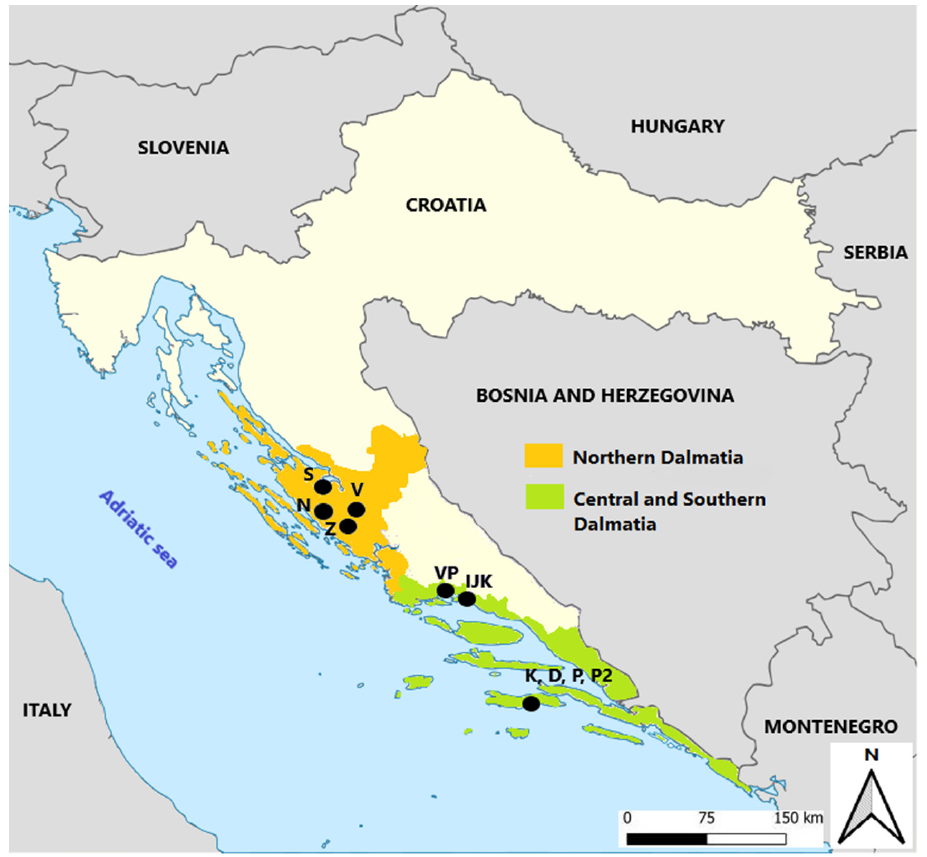
Figure 1. Geographic locations of 10 vineyards in the vine growing subregions: Northern Dalmatia (N—Pola č a, S—Smil č i ć , Z—Stankovci, V—Vukši ć ), Central and Southern Dalmatia (IJK—Institute for Adriatic Crops and Karst Reclamation, VP—Kaštela; on the island of Kor č ula: K—Kruševo, D—Dra č evica, P—Prapatna 1, P2—Prapatna 2).